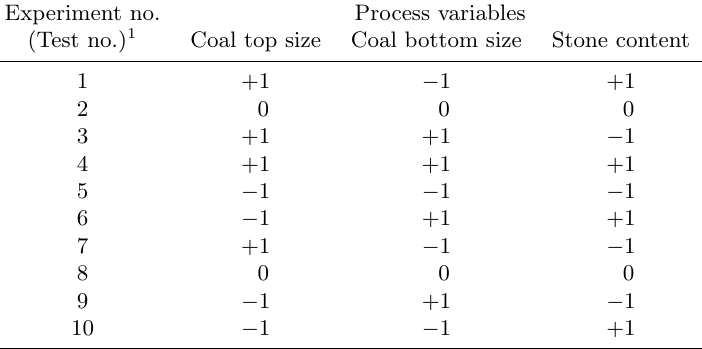
Table 1: Experimental design layout in coded